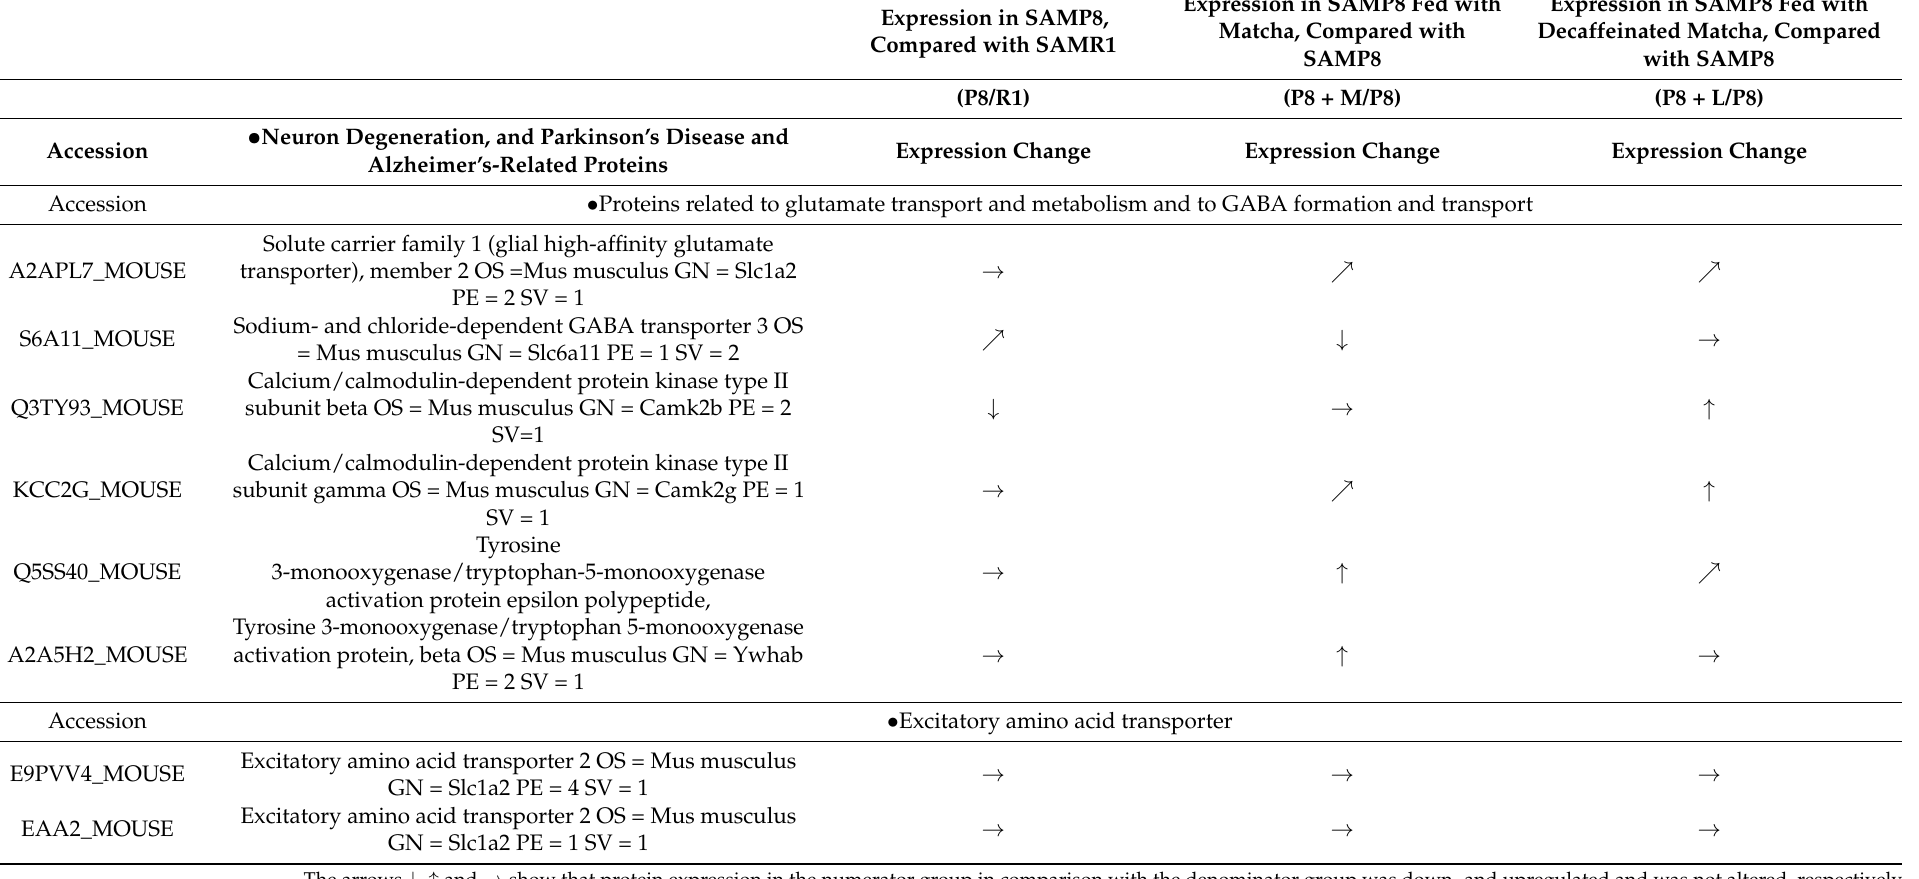
Expression in SAMP8,